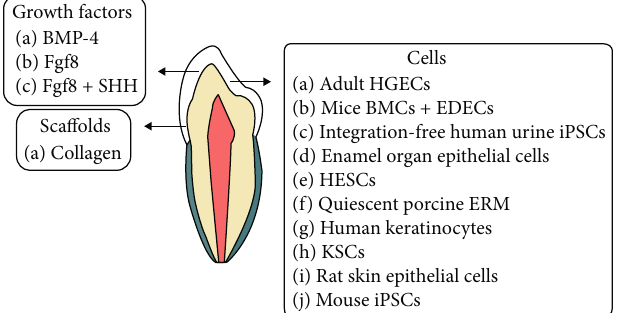
Figure 1: Diagram showing cells, growth factors, and sca ff olds examined in the fi eld of enamel